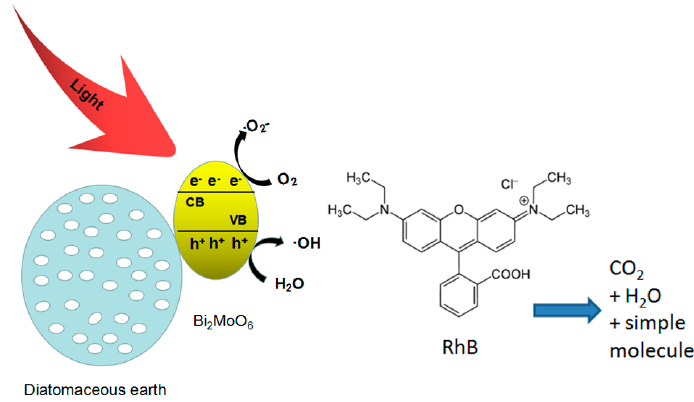
Figure 10. Schematic diagram of a possible photocatalytic mechanism about nano-Bi 2 MoO 6 /diatomite under visible irradiation.